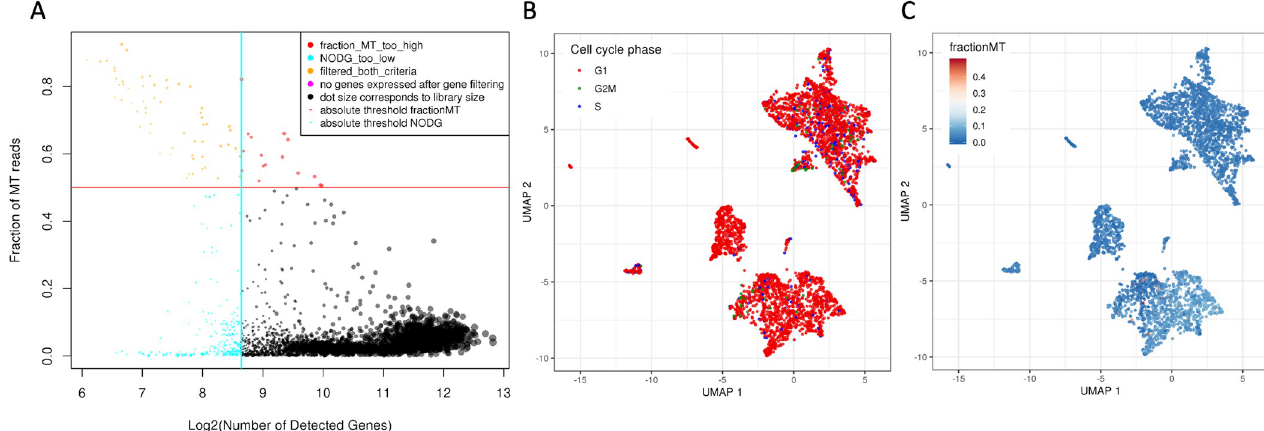
Fig 2. Examples of scAmpi’s basic scRNA-seq quality control plots of a melanoma sample. The scatter plot in (A) shows cells colored by their respective category of applied filters. The vertical and horizontal lines indicate the chosen thresholds applied for the minimum number of genes (x-axis) and maximum fraction of reads mapping to mitochondrial genes per cell (y-axis), respectively. In (B), the UMAP embedding (after normalization) of all cells is shown, with cells colored by estimated cell-cycle phase. In (C), the same UMAP is shown, this time with cells colored by the fraction of reads mapping to mitochondrial